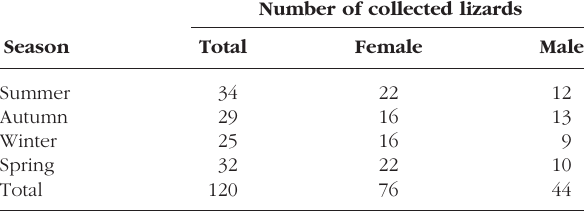
Table I. – The structure of the sampled host population by the season of captured and host